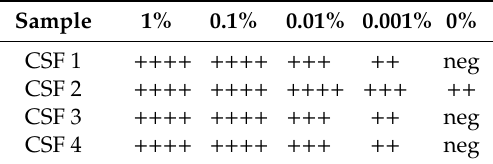
Table 1. Results from the Combur10-Test Strip analysis for the four investigated CSF samples (CSF 1–4).